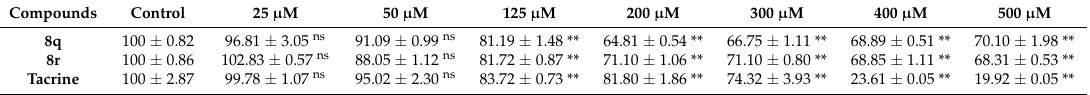
Table 2. In vitro cytotoxicity of tacrine and ligustrazine hybrids 8q and 8r in HepG2 cells a,b . Compounds Control Compounds